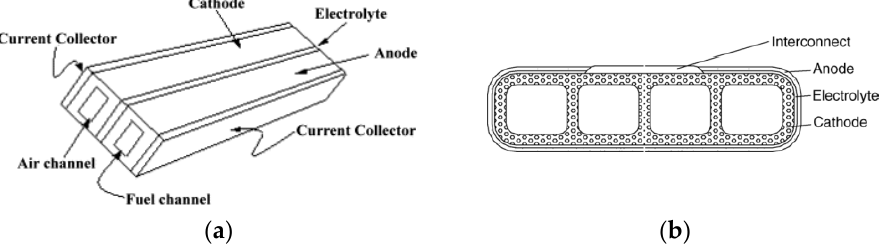
Figure 5. Schematic of the: ( a ) monolith type fuel cell modelled and ( b ) HPD-SOFC (figure reprinted from Singhal, S.C [34] Copyright (2000), with permission from Elsevier). from Singhal, S.C [34] Copyright (2000), with permission from Elsevier).